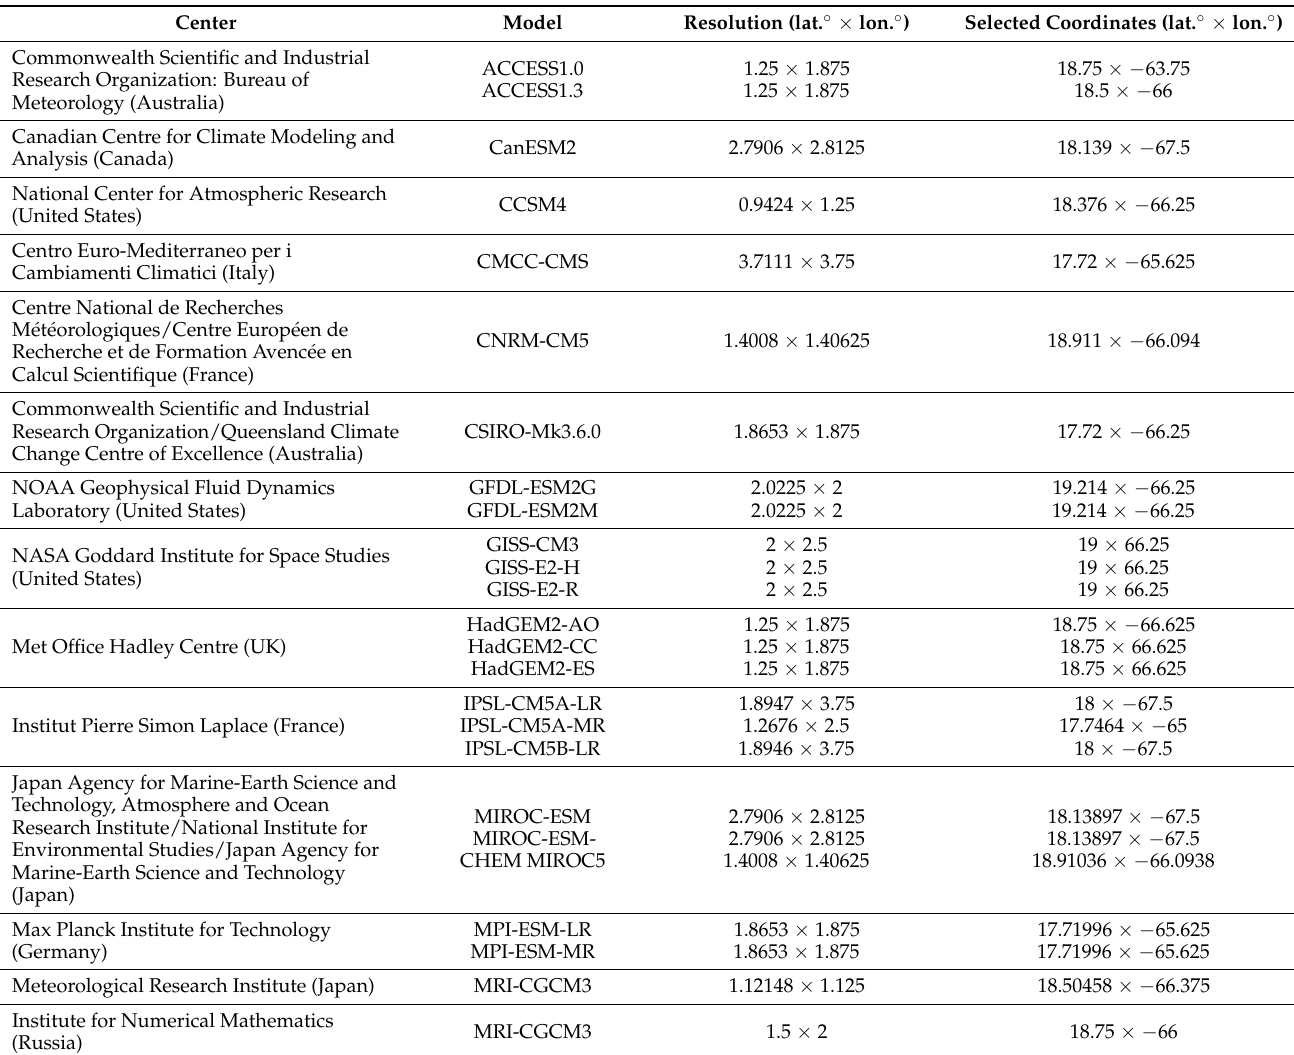
Table 1. Twenty-five-model ensemble and center of origin used in single-point heat wave projections based on location of SJIA (18.3522 lat. ◦ × − 66.1186 lon. ◦